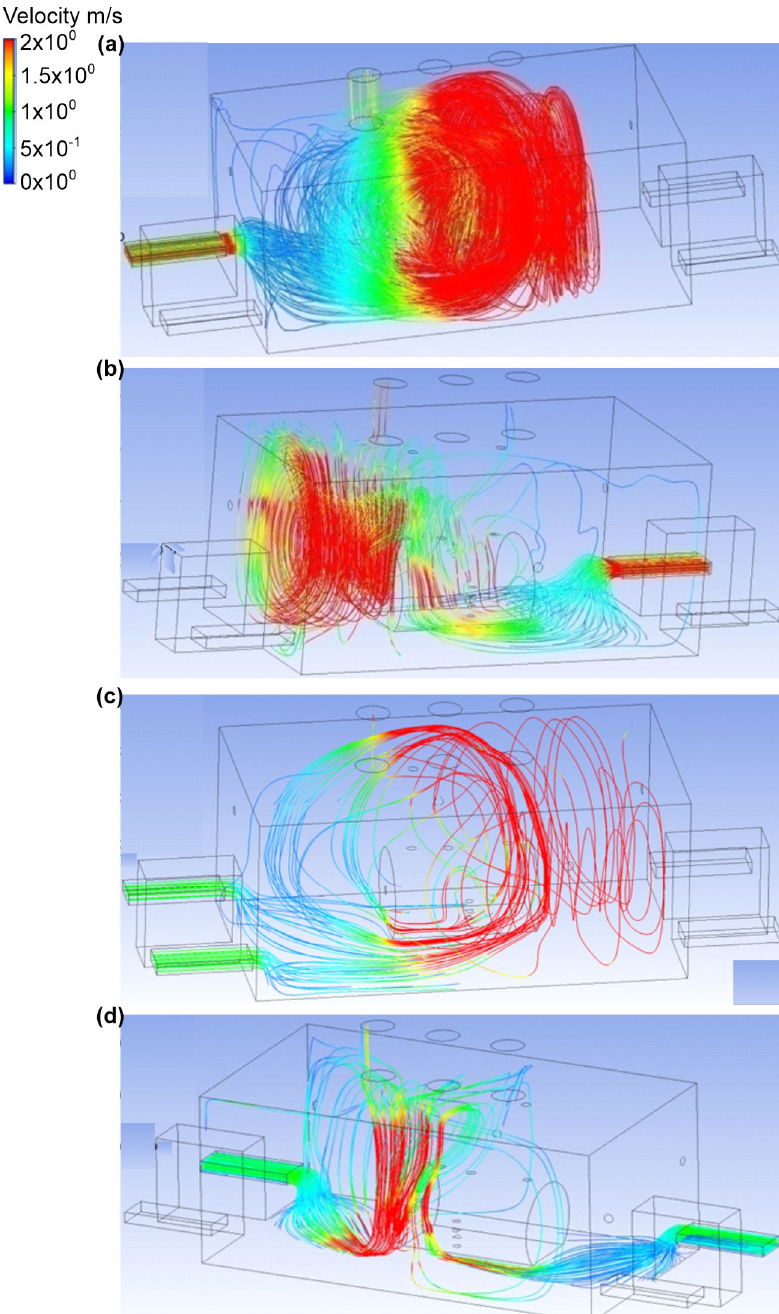
Figure 3. Velocity distribution in the engine room for: ( a ) scenario A, ( b ) scenario B, ( c ) scenario C, and ( d ) scenario D.